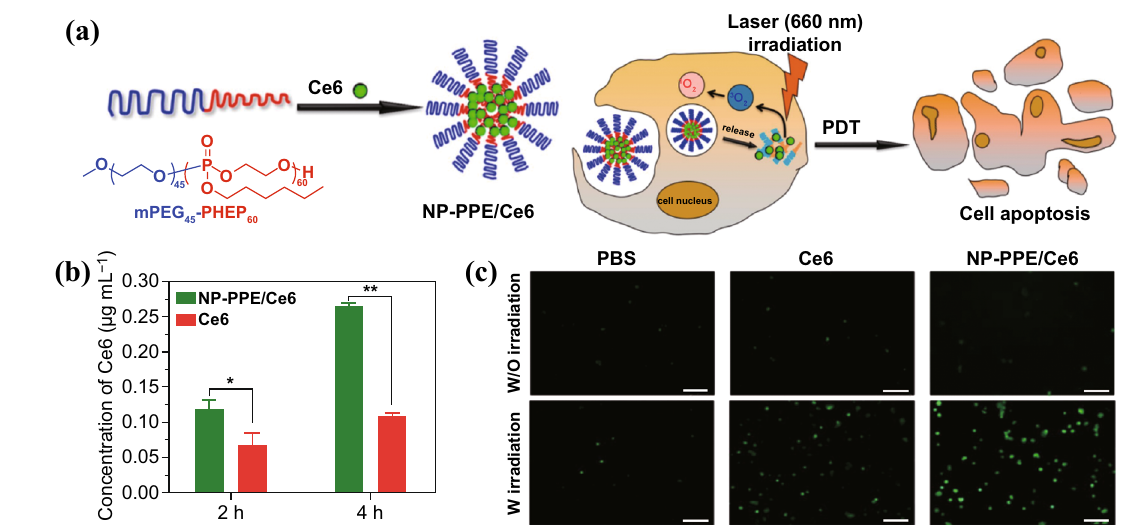
Fig. 2 a Schematic illustration of Ce6 encapsulation by self-assembly of amphiphilic mPEG-b-PHEP and intracellular delivery of Ce6 with NP- PPE. b Quantitative Ce6 concentration in the BxPC-3 cancer cells. c CLSM image of cells incubated with DCF and then treated with free Ce6 and NP-PPE/Ce6 with NIR laser irradiation. Adapted with permission from Ref. [36]. Copyright © 2015, American Chemical